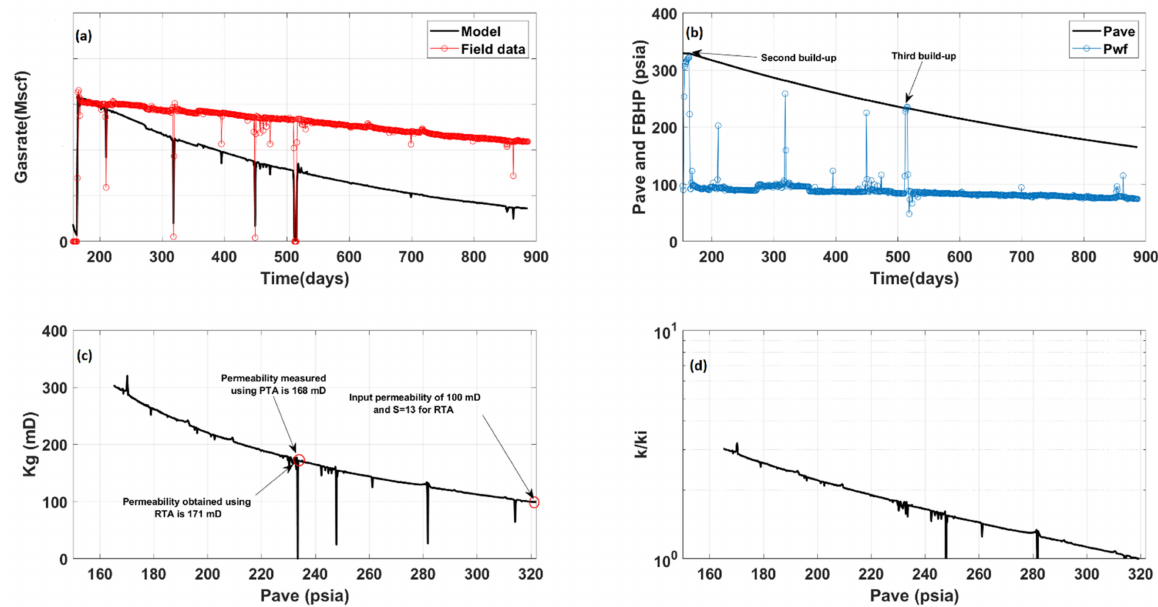
Figure 12. Integration of rate transient analysis and pressure transient analysis to obtain the functional form of permeability change [155] (This figure was originally published in The APPEA Journal Vol 59 No 1). ( a ) Comparison of field data with tank type model when permeability is constant, ( b ) bottom-hole flowing pressures and average reservoir pressures, ( c ) permeability function obtained using RTA, ( d ) the semi-log plot of permeability ratio as a function of average reservoir pressure is a straight-line (exponential